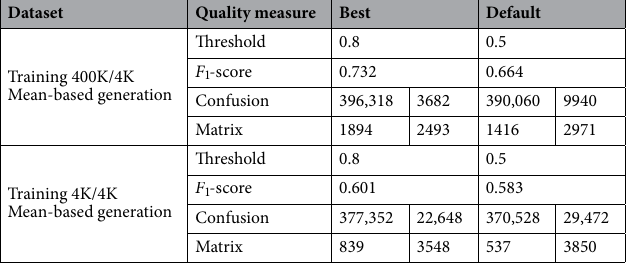
Table 4. Baseline results using a naive mean-based generator for